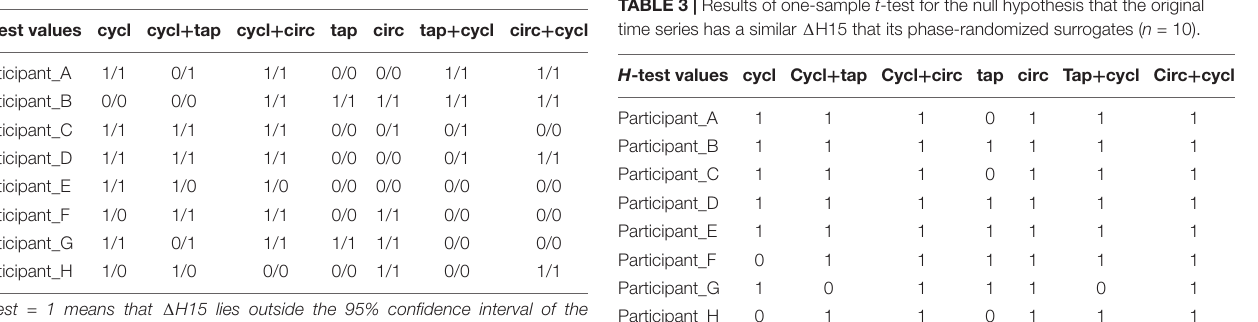
TABLE 2 | Comparison of (cid:49) H15 in original time series with the average (cid:49) H15 of strictly monofractal surrogates using either Davies and Harte simulated series ( n = 40) or ARFIMA (0,d,0) simulated series.